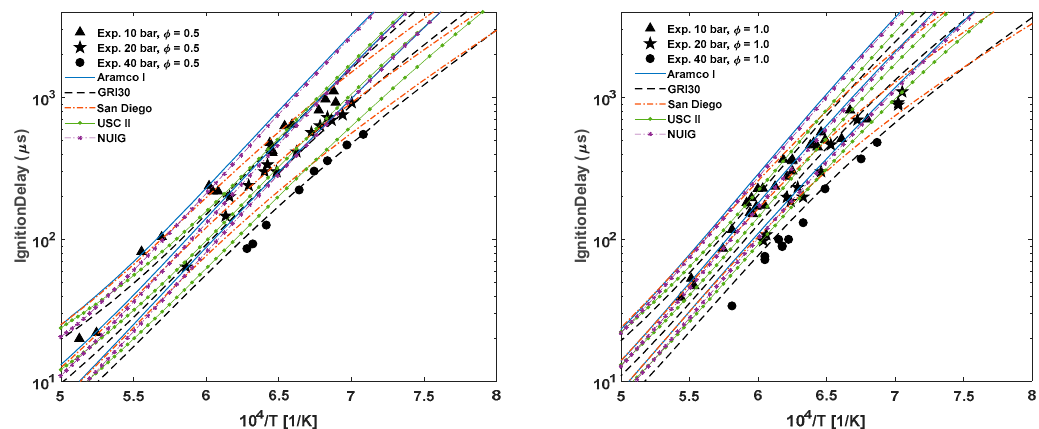
Figure 2. Comparison of methane ignition delay time for different mechanisms with the experimental data at p = 10, 20, 40 bar and, left : φ = 0.5; right : φ = 1.0 [38].